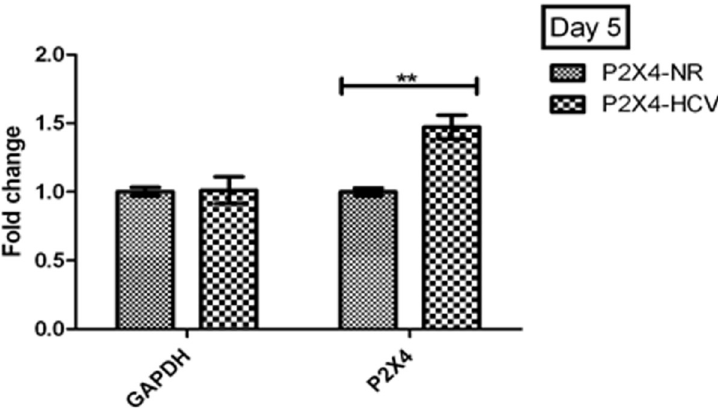
Fig 11. Expression of P2X4 gene at day 5 of post infection with HCV. All values are expressed as mean ± SEM, � P � 0.05 vs. control P2X4-NR cells.